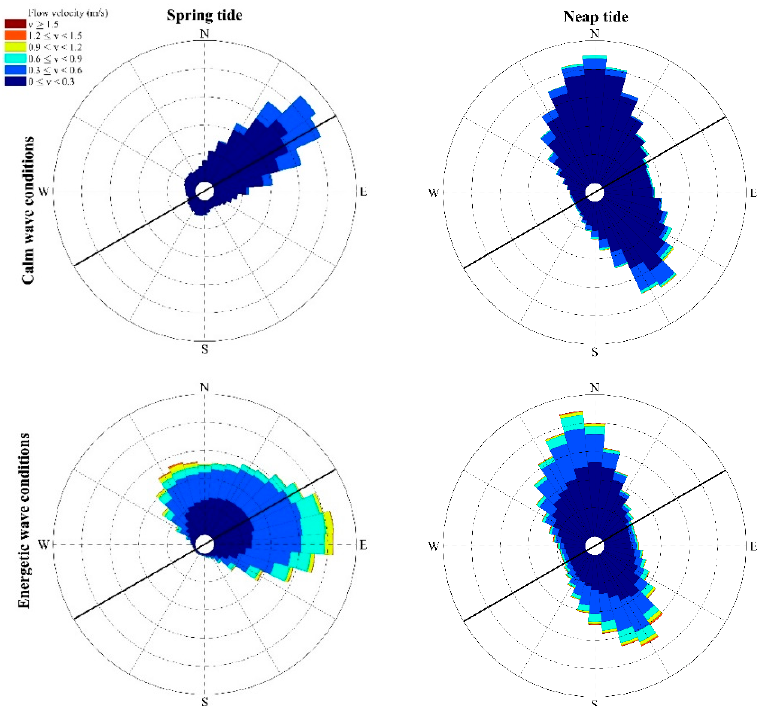
Figure 4. Typical current roses for spring vs. neap tide (left vs. right panels) and calm vs strong waves (top vs. bottom panels). Currents were measured at 35 cm above the bed at Mariakerke and currents are not included for water levels < 2.39 m TAW. The shoreline orientation is indicated by the black line. Each current rose represents one tidal cycle.